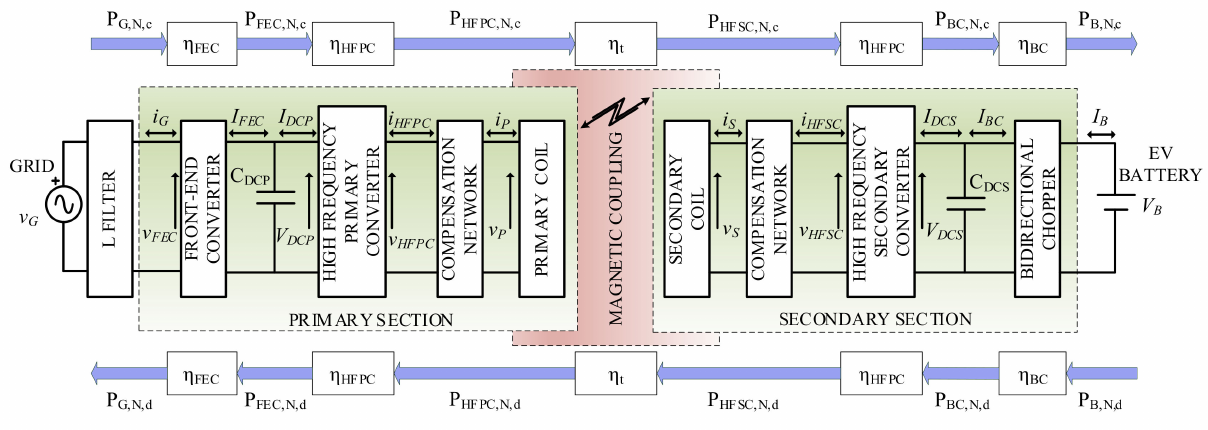
Figure 3. BWV2H block